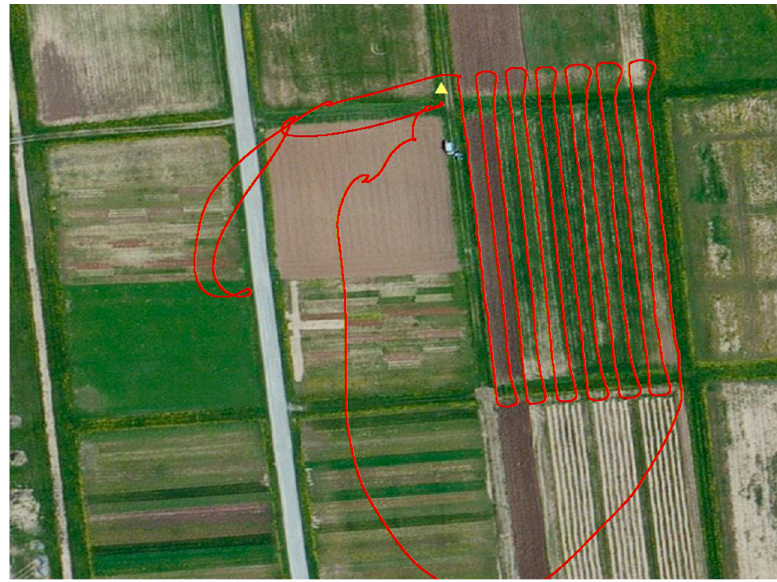
Figure 4. Cruise route of the DJI Matrice 100.